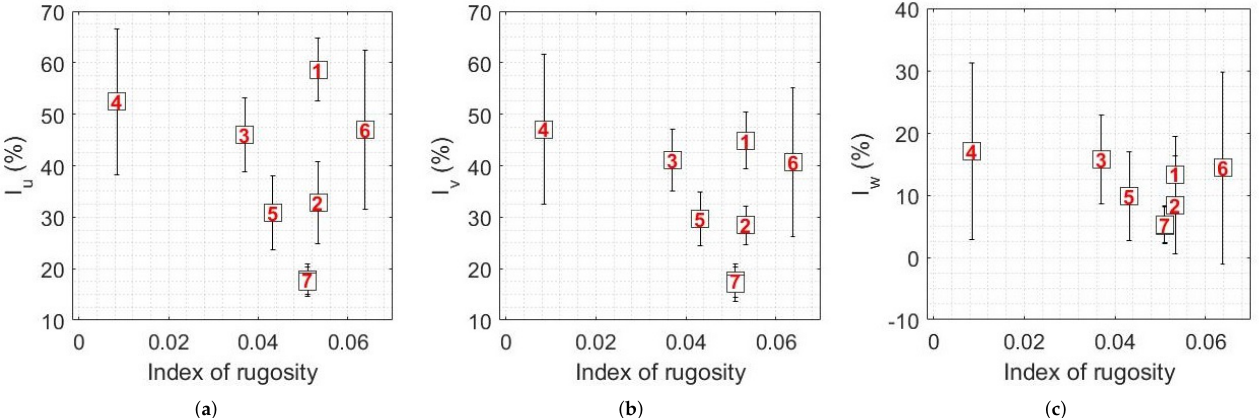
Figure 12. Turbulence intensity at 110m AGL in the along-wind ( a ), lateral ( b ) and vertical ( c ) direction with regard to index of rugosity for different Bora episodes, labeled by their ordinal number. The index of rugosity represents the orographic complexity of the 4km path upstream of the measurement site. Note: data points of wind episodes 7 and 8 overlap.